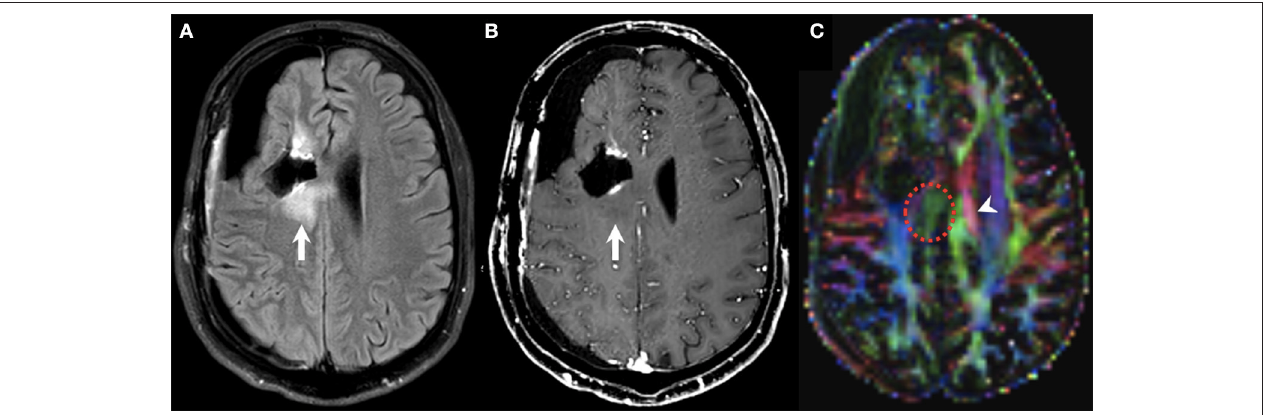
FIGURE 3 | Diffusion tensor imaging (DTI) in pseudoresponse. Follow-up brain MRI of a 30-years-old male person with a diagnosis of GBM (NOS, MGMT status unknown) after standard-of-care treatment, currently on bevacizumab therapy. FLAIR (A) , contrast-enhanced T1w (B) , and DTI (C) axial images. A new area of non-enhancing FLAIR hyperintensity is noted along the posterior aspect of the right frontal surgical cavity (arrows on A,B ) that was considered as infiltrative tumor based on other functional MRI sequences (not shown). DTI unveils the disruption of the corpus callosum fibers subjacent to the lesion (dotted circle on C ) compared to the normal contralateral side (arrowhead on C ) as a marker of tumor